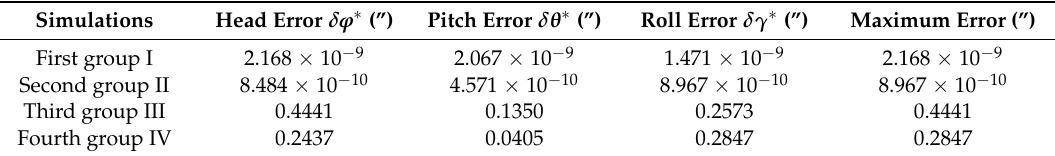
Figure 6. The third group III simulation with rotation in the X axis ω b Table 1. Attitude angle errors (RMSE (root mean square error)) solved by the convected Euler angle error model.